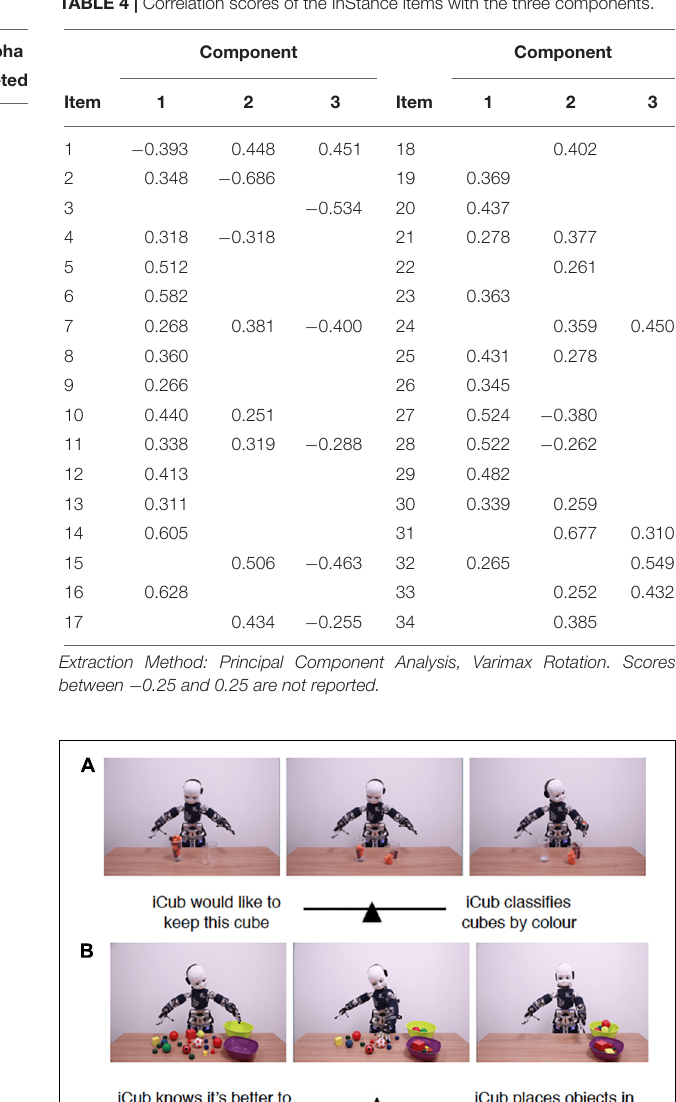
TABLE 3 | Results of the item analysis. TABLE 4 | Correlation scores of the InStance items with the three components.